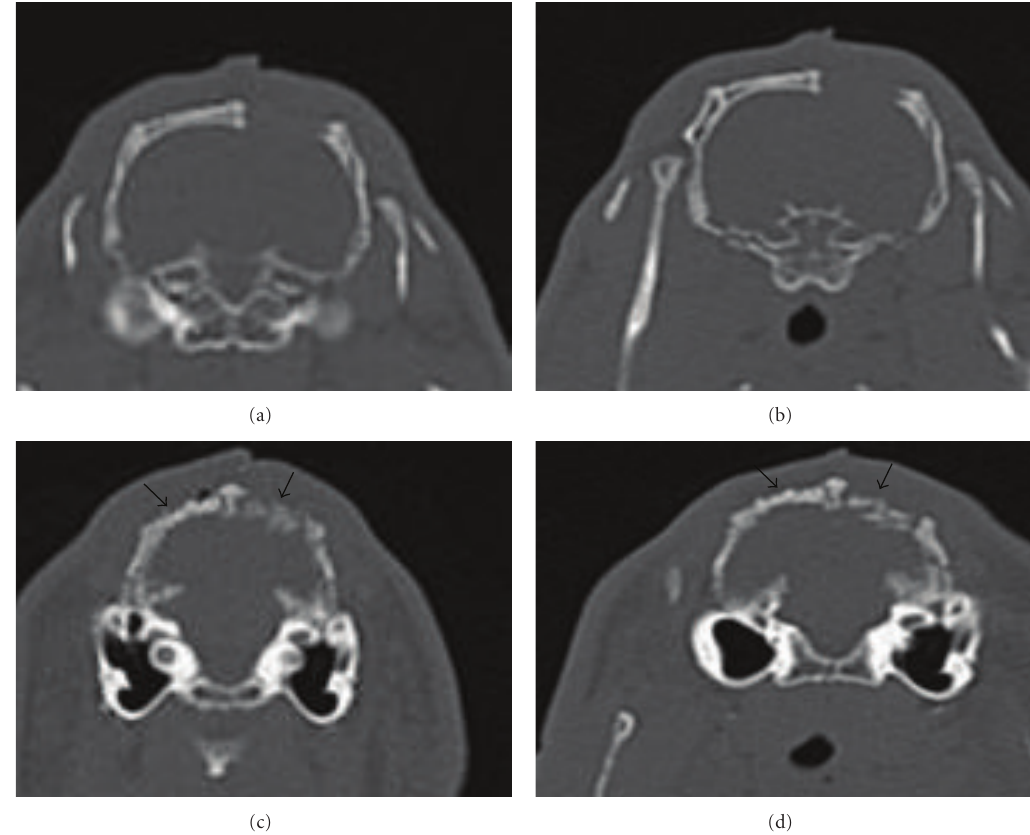
Figure 2: Post-op CT scan of (a) unfilled area immediately after surgery; (b) unfilled area 1 week post operatively; (c) dentin-filled defect (left arrow) and the autogenous bone-filled defect (right arrow) immediately after surgery; (d) dentin-filled defect (left arrow) and the autogenous bone-filled defect (right arrow) 1 week